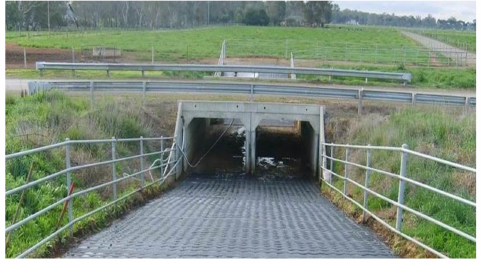
Figure 2. An example of an underpass in Victoria, Australia.